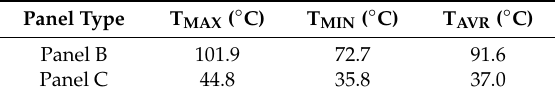
Table 5. Temperatures for the second series of tests.